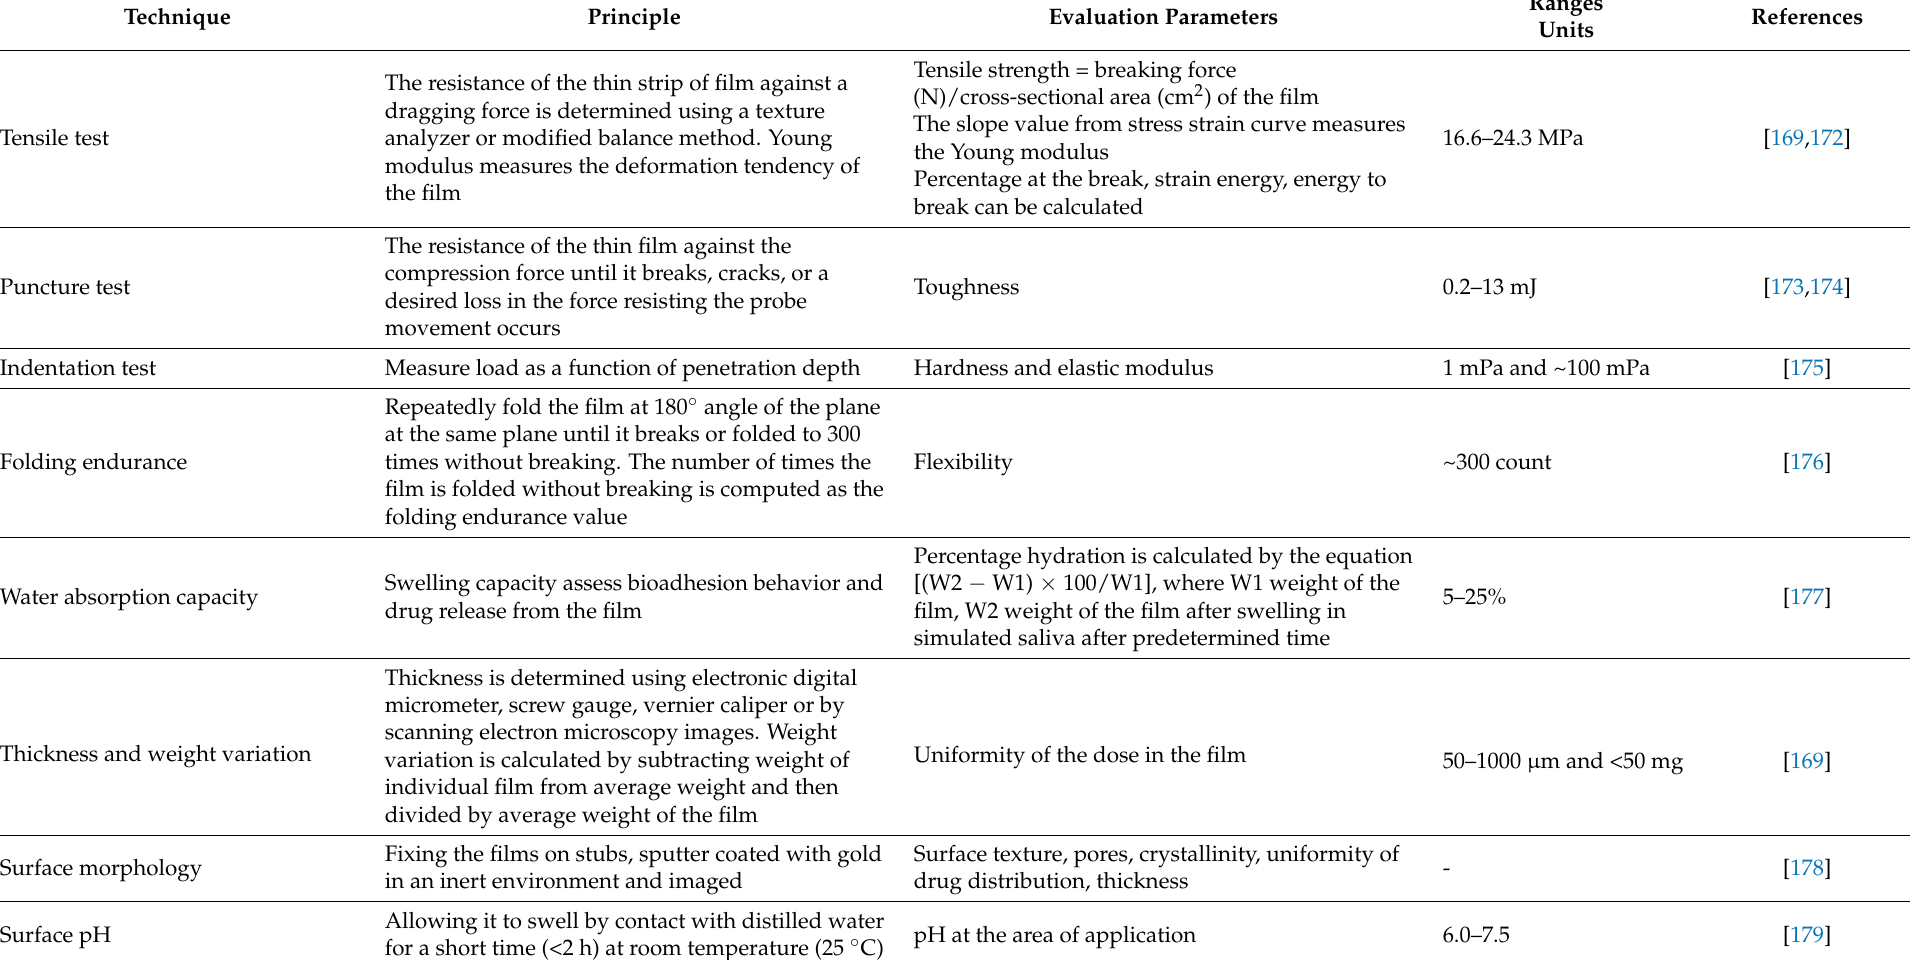
Table 5. In vitro evaluation techniques typically employed for buccal